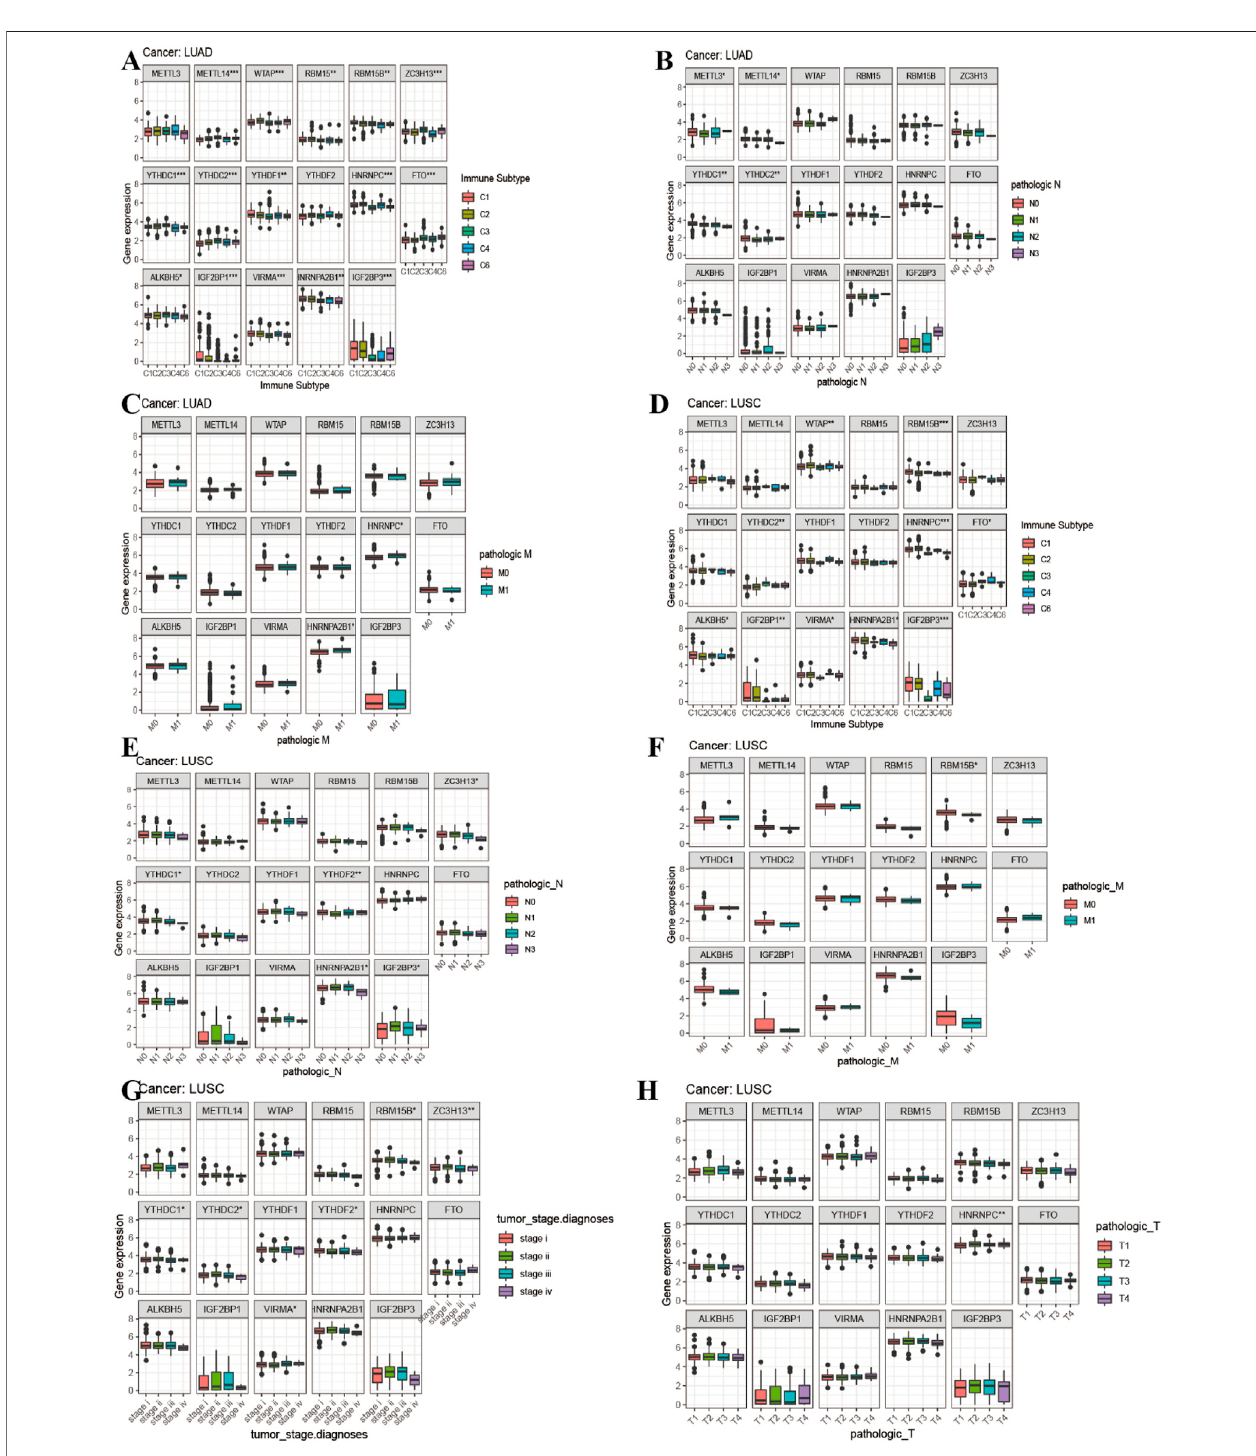
FIGURE 8 | Correlation analysis between 17 m6A regulators expression and clinical characteristics in LUAD and LUSC. (A) Differences in m6A gene expression of LUAD between different immunophenotypes. (B – C) The boxplot of expression of 17 m6A-related genes and clinical features in LUAD. (D) Differences in m6A gene expression of LUSC between different immunophenotypes. ( E – H) The boxplot of expression of 17 m6A-related genes and clinical features in LUSC.